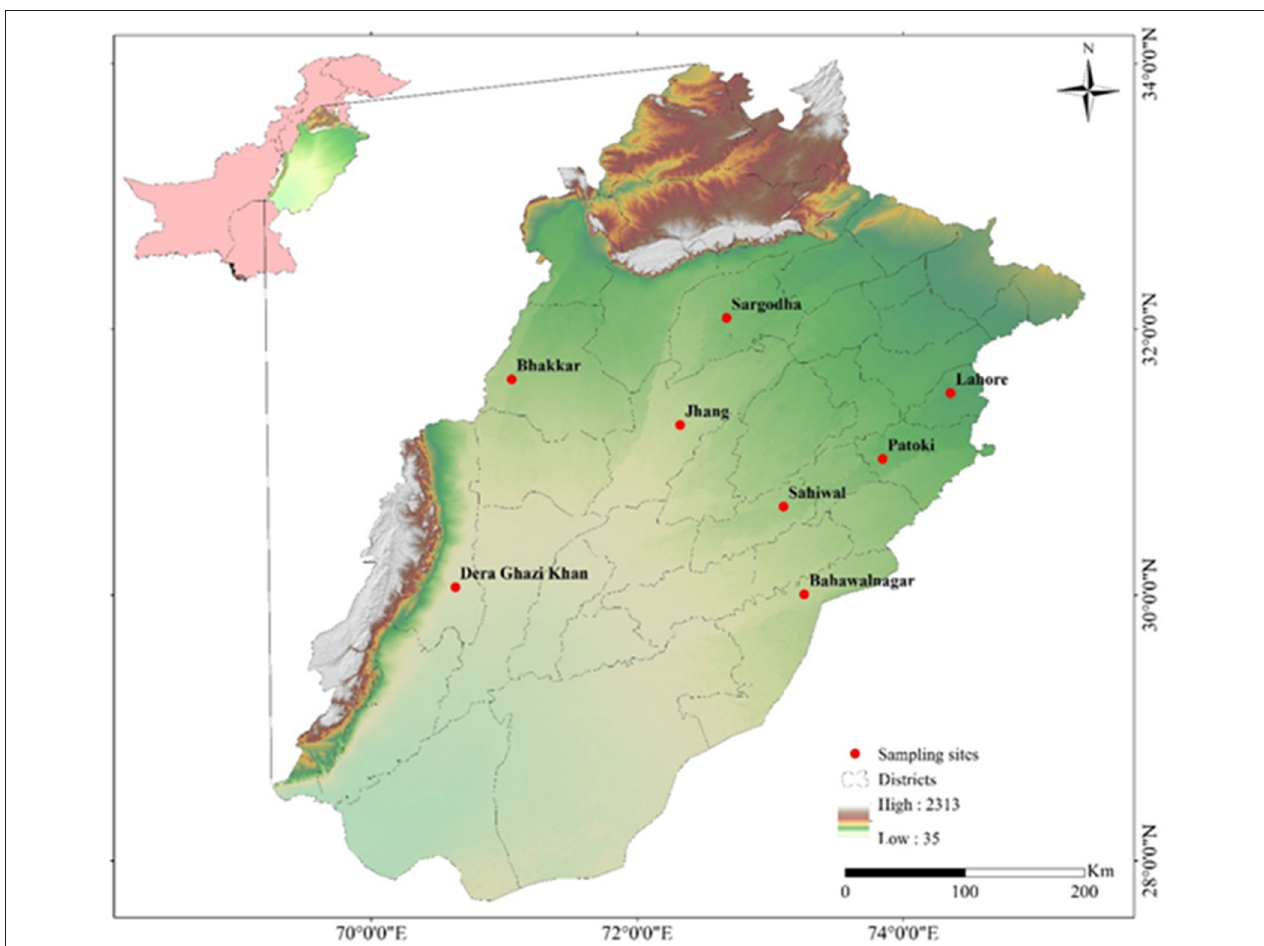
FIGURE 1 | Map showing sampling sites (Buffalo, Cattle) of different cities of Punjab province, Pakistan generated by ArcGIS 10.2.2 software (ESRI, Redlands, CA, USA) by using Shuttle Radar Topography Mission (SRTM) Digital Elevation